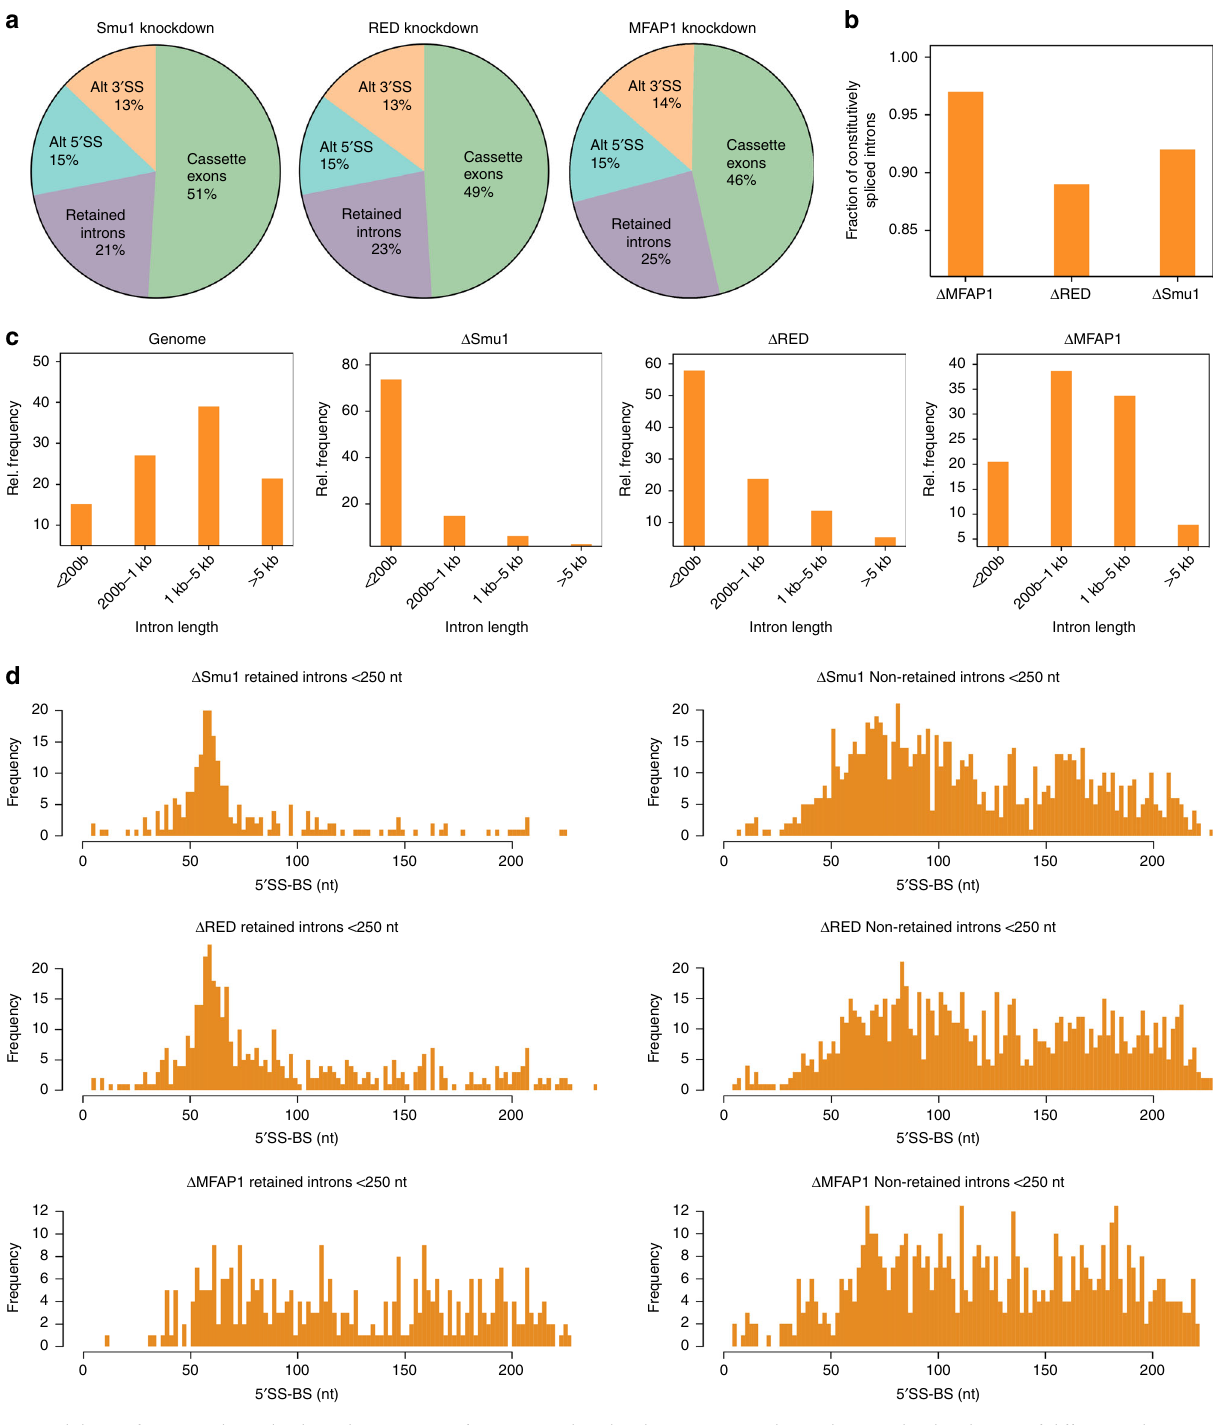
Fig. 1 Knockdown of Smu1 and RED leads to the retention of constitutively spliced introns. a Pie charts showing the distribution of different splicing events altered in HeLa cells after knockdown of Smu1, RED or MFAP1, as determined by RNA-seq. Usage of alternatively spliced (Alt) 3 ′ or 5 ′ splice sites, changes in the inclusion or skipping of cassette exons, and retention of introns are indicated. b Fraction of constitutively spliced introns among those retained (unspliced) upon knockdown of Smu1, RED or MFAP1. c Introns were sorted into 4 classes according to their length — i.e. <200 bases, 200 – 1 Kb, 1 – 5 Kb and >5 Kb. Charts showing the relative distribution of these 4 intron length classes in the genome or in those introns retained after Smu1, RED or MFAP1 knockdown. d 5 ′ SS to BS distances in short introns (<250 nts long) retained after Smu1, RED or MFAP1 knockdown versus non-retained short introns with a matching intron-length distribution. The observed distributions for retained versus non-retained (unaffected) short introns are signi fi cantly different for Δ Smu1 and Δ RED ( p -value < 1e − 12, two-sided, two sample Smirnov – Kolmogorov test), but not for Δ MFAP1 ( p -value >